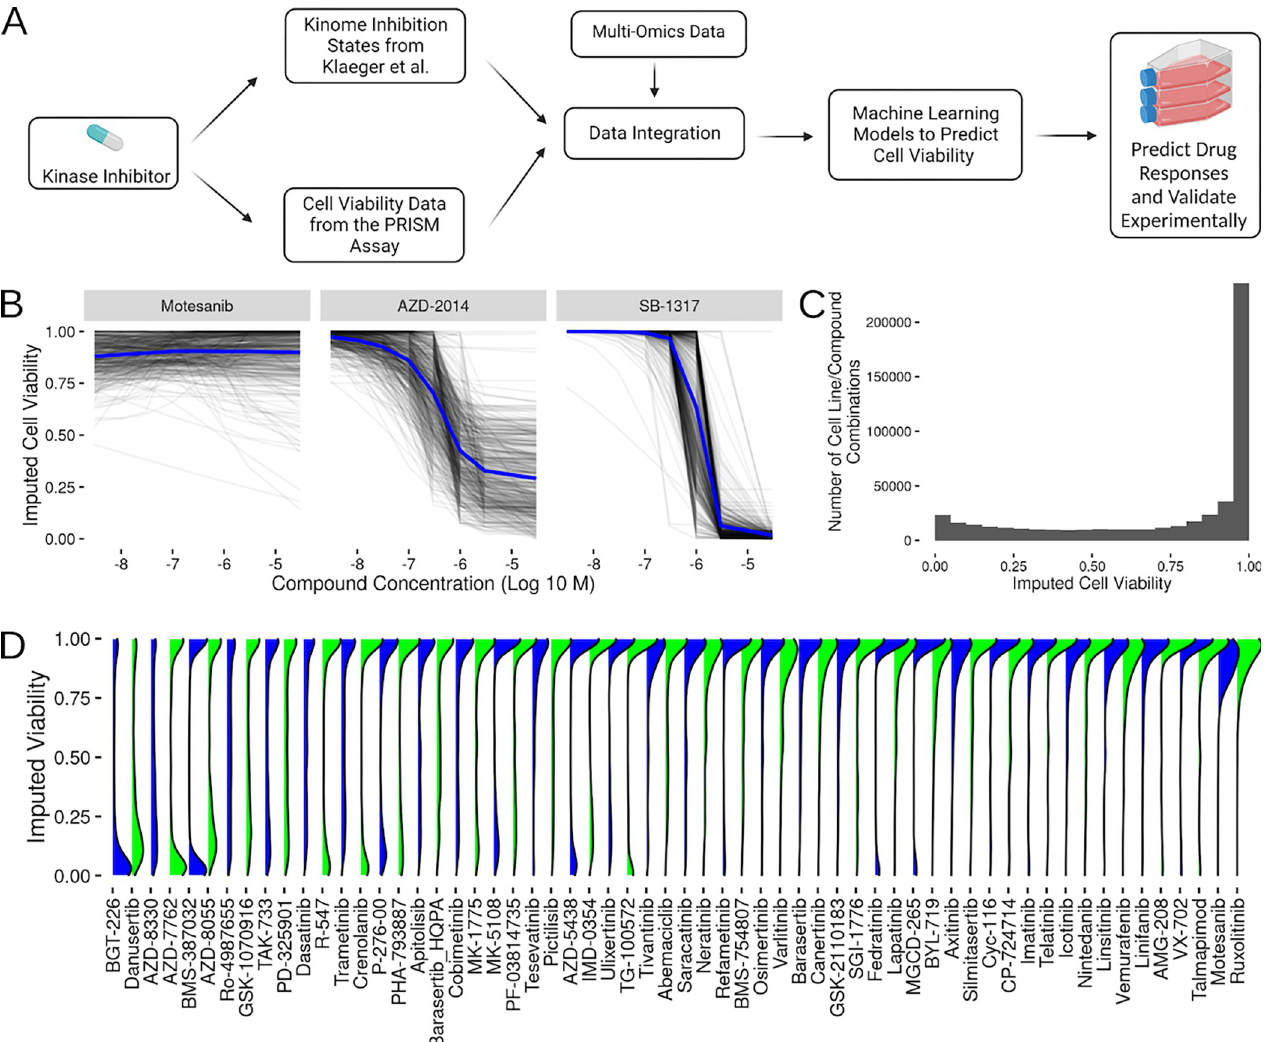
Fig 1. Study Design Overview and Imputation of Cell Viability from PRISM. (A) Flow chart showing data source collection, integration and modeling strategy. (B) Sample imputed cell viability curves for all assayed cell lines (gray underlying lines) and corresponding average imputed cell viability response (blue line) for three compounds showing low changes (Motesanib), medium level changes (AZD-2014) and high changes (SB-1317) in cell viability. (C) Overall distribution of cell viability values imputed at Klaeger et al compound concentrations. (D) Distribution of imputed cell viability across all concentrations for a selection (60 out of 168) sampled evenly across the average imputed cell viability effect of the compounds present in both PRISM and the Klaeger et al set. The blue and green color scheme does not indicate anything about the underlying data and is meant to act as a visual aid for differentiating between adjacent curves. (Panel A was created with